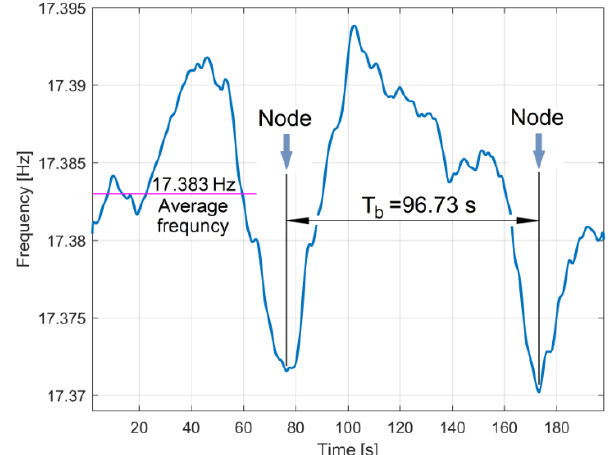
Figure 11. The evolution of the instantaneous combination frequency f c during the vibration beating phenomenon (displacement of headstock) described in Figure 7. Figure 12. The evolution of the low pass filtered instantaneous combination frequency f c during the vibration beating phenomenon described in Figure 7 (a low pass filtering of Figure 11).